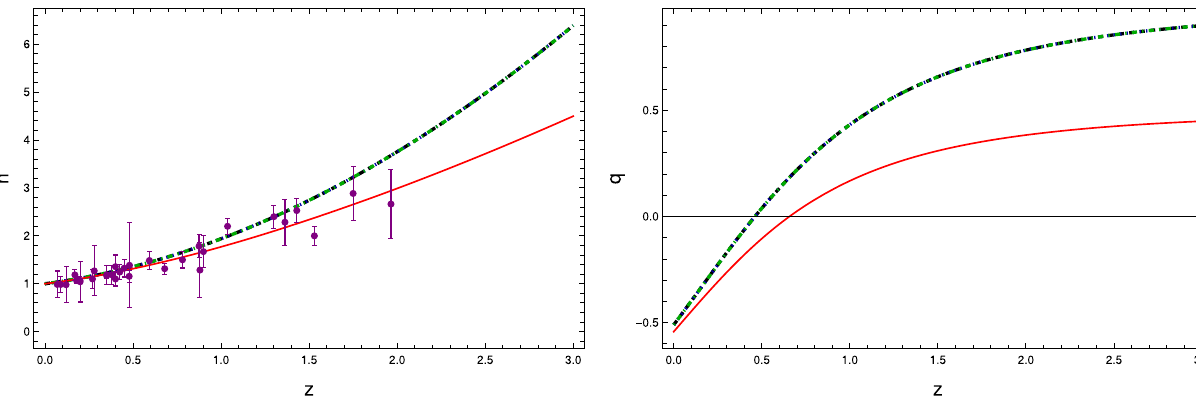
Fig. 3 The Hubble function h ( z ) and the deceleration parameter q ( z ) for the conformally invariant quadratic Weyl cosmological model (91), for lower 2 σ limit (dashed), best fit (dot-dashed), and upper 2 σ limit